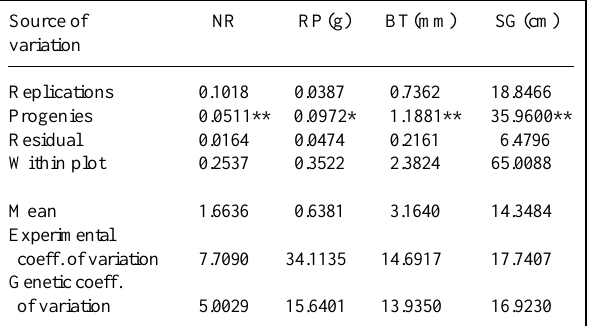
Table I - Mean square values of ANOVA for total number of vessel rings (NR), rubber production (RP), bark thickness (BT) and stem girth (SG) for three-year-old progenies of Hevea